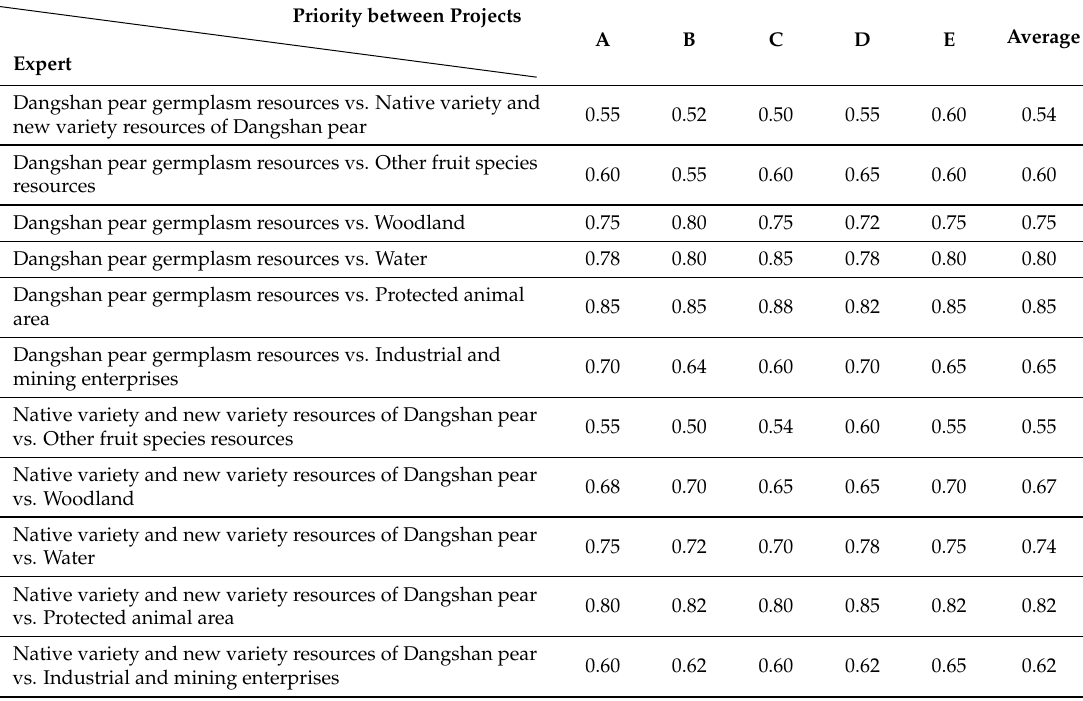
Table 5. Survey data on the role of